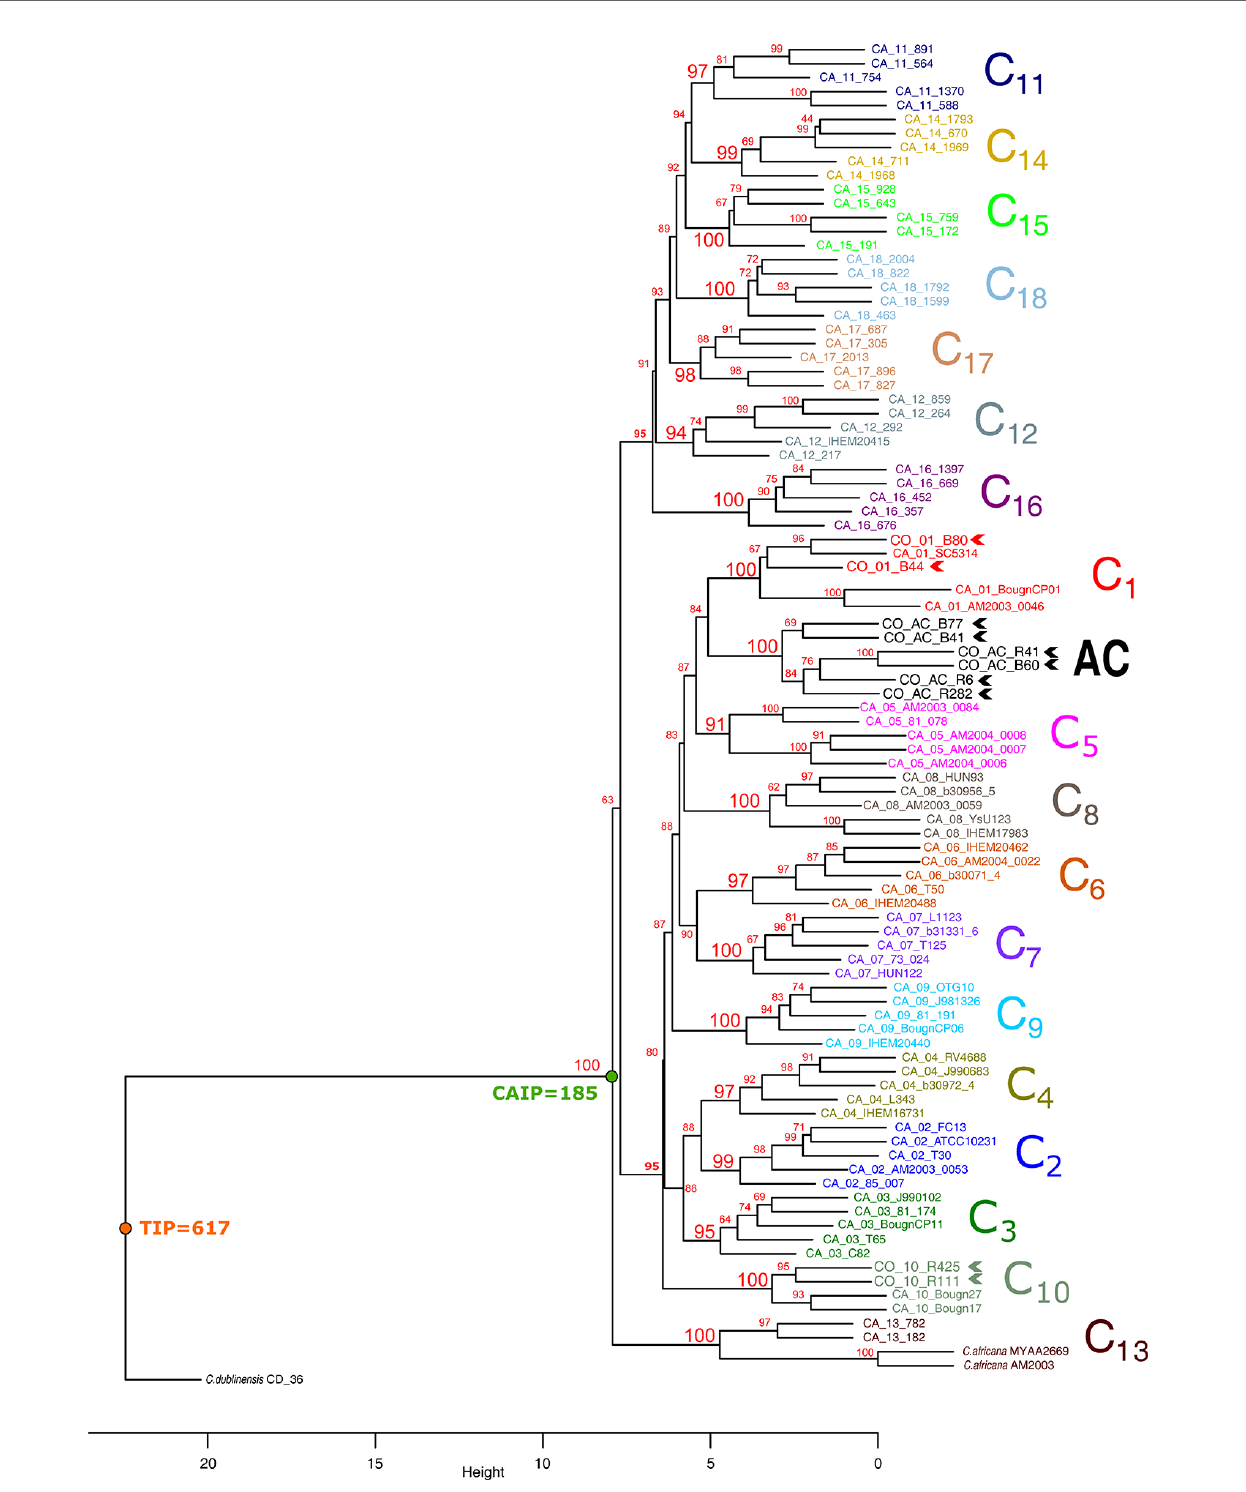
FIGURE 2 | Cluster analysis of MLST data, using the UPGMA method. Each clade is shown in a different colour. Colombian isolates are indicated in bold and chevrons. Bootstrap values above 95% were considered signi fi cant. Large numbers in red denote support for each clade. TIP: total informative positions, CAIP: C. albicans informative